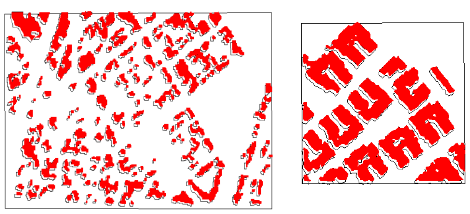
Figure 10: the modeling steps